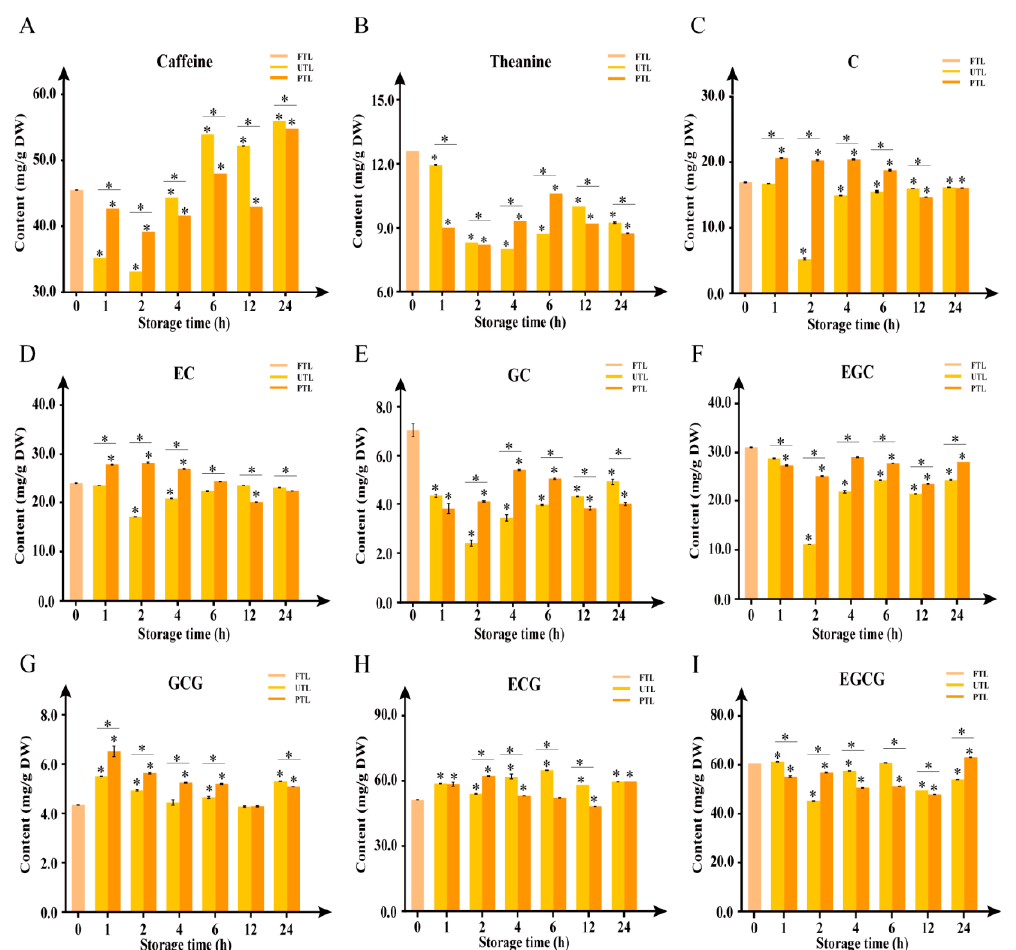
Figure 2. Changes in caffeine ( A ), theanine ( B ), and catechin ( C – I ) contents in preserved (PTL) and unpreserved (UTL) up to 24 h postharvest. C, catechin; EC, epicatechin; GC, gallocatechin; EGC, epigallocatechin; ECG, epicatechin gallate; GCG, gallocatechin gallate; EGCG, epigallocatechin gallate. Dunnett’s multiple comparisons and t -test identified significant differences (*, p < 0.05). Values are the mean ± SEM of all replicates.